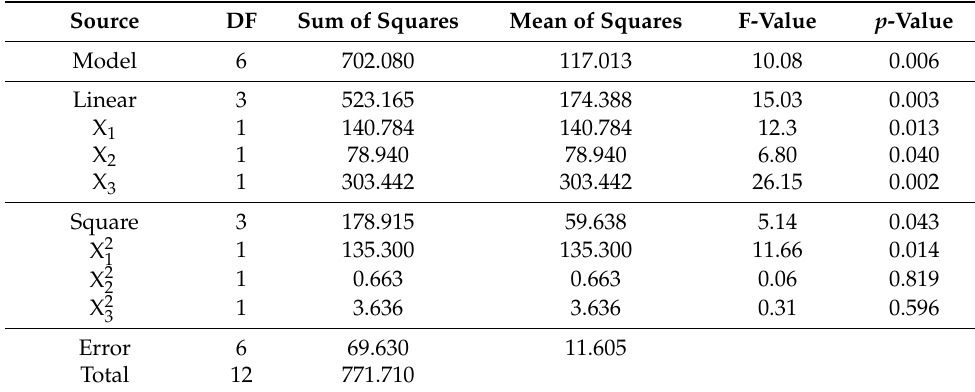
Table 12. Analysis of variance for the work of adhesion (W) response.